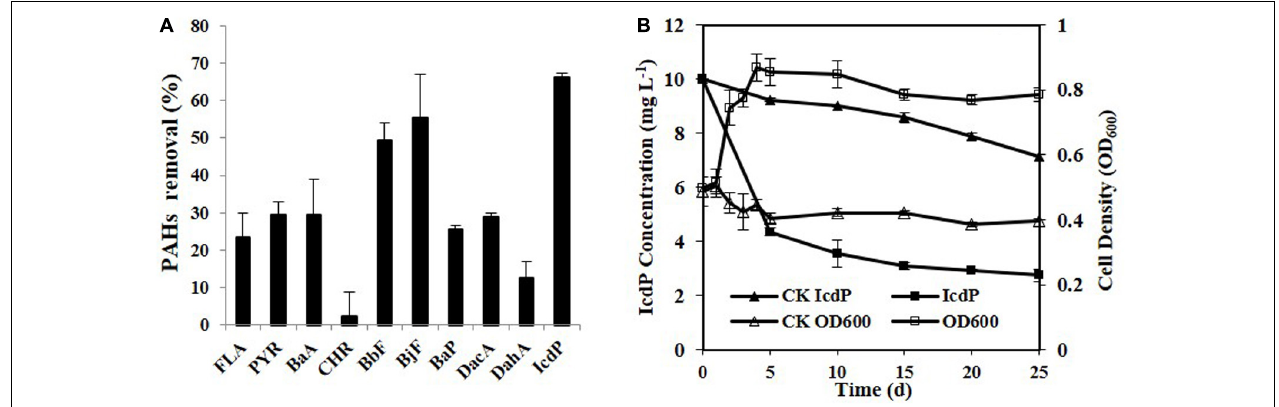
FIGURE 1 | Degradation of various HMW PAHs (10 mg/L) by strain IcdP1 in MSM (A) , microbial growth, and IcdP degradation (B) ; negative control was expressed as CK. Values are means ± SD (error bars) for three replicates.